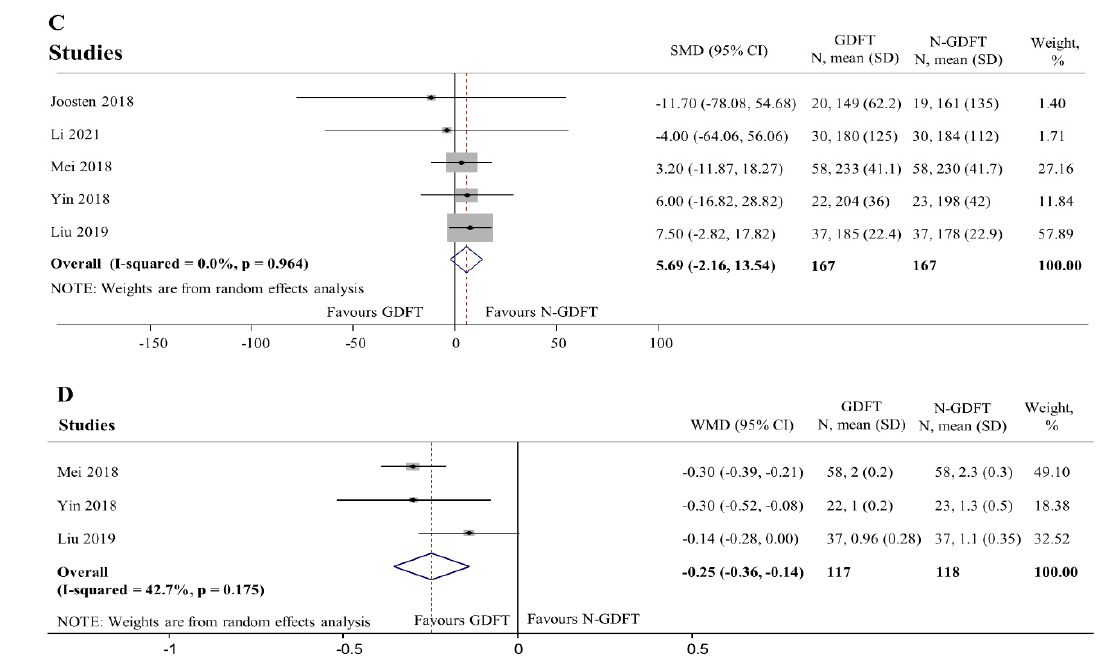
Figure 4. Clinical outcomes at the end of operation. Intraoperative fluid requirement ( A ) was signif- icantly lower (WMD = − 440.84 mL; 95% CI: − 789.73 mL to − 91.96 mL) in the GDFT group. High heterogeneity was detected (I-squared = 96.9%, p < 0.01). There was no significant difference in the num- ber of patients requiring vasopressors intraoperatively ( B ) between the goal- and the non-goal-directed groups. (RR = 0.90; 95% CI = 0.71 to 1.14). Low heterogeneity was found (I-squared = 44.0%; p < 0.01). There was no significant difference in intraoperative urinary output standardised for length of surgery ( C ) between the two groups (SMD = 5.69 mL h − 1 ; 95% CI = − 2.16 mL h − 1 to 13.54 mL h − 1 ). Data were not considered heterogeneous (I-squared = 0.0%; p = 0.96). Serum lactate levels ( D ) were significantly lower in the GDFT group compared to N-GDFT (WMD = − 0.25 mmol L − 1 ; 95% CI − 0.36 mmol/ to − 0.14 mmol L − 1 ). There is no evidence for heterogeneity (I-squared = 42.7%; p = 0.18). WMD: weighted mean difference, SMD: standardised mean difference, RR: risk ratio, SD: standard deviation. GDFT: goal- directed fluid therapy, N-GDFT: non-goal-directed fluid therapy, CI: confidence interval. p < 0.1 was considered